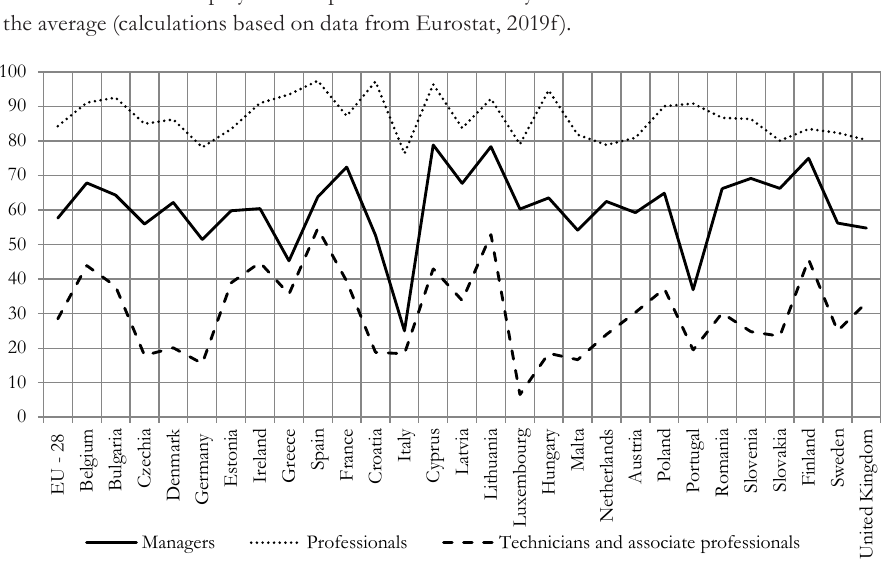
Fig. 2 – Share of employed population with tertiary education by major occupational groups in the EU in 2017 (in %). Source: calculated by authors, based on data from Eurostat